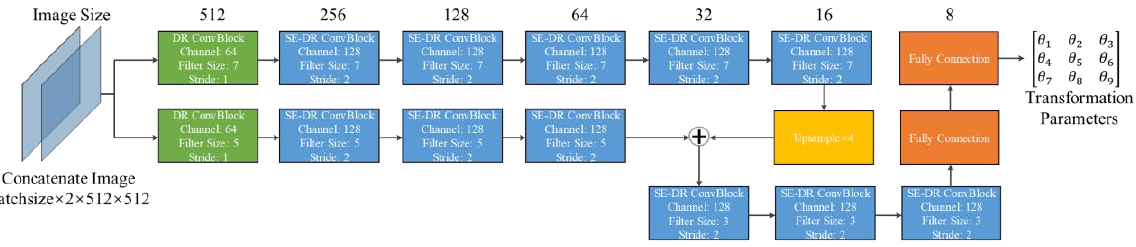
Figure 3. Architecture of DNN architecture in scale 3.